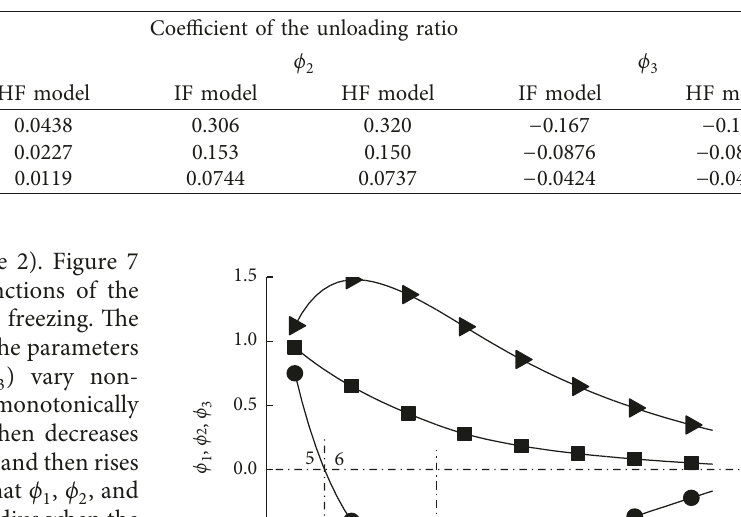
Table 2: ϕ , ϕ , and ϕ at the outer edge of the frozen wall and for different freezing modes. 1 2 3